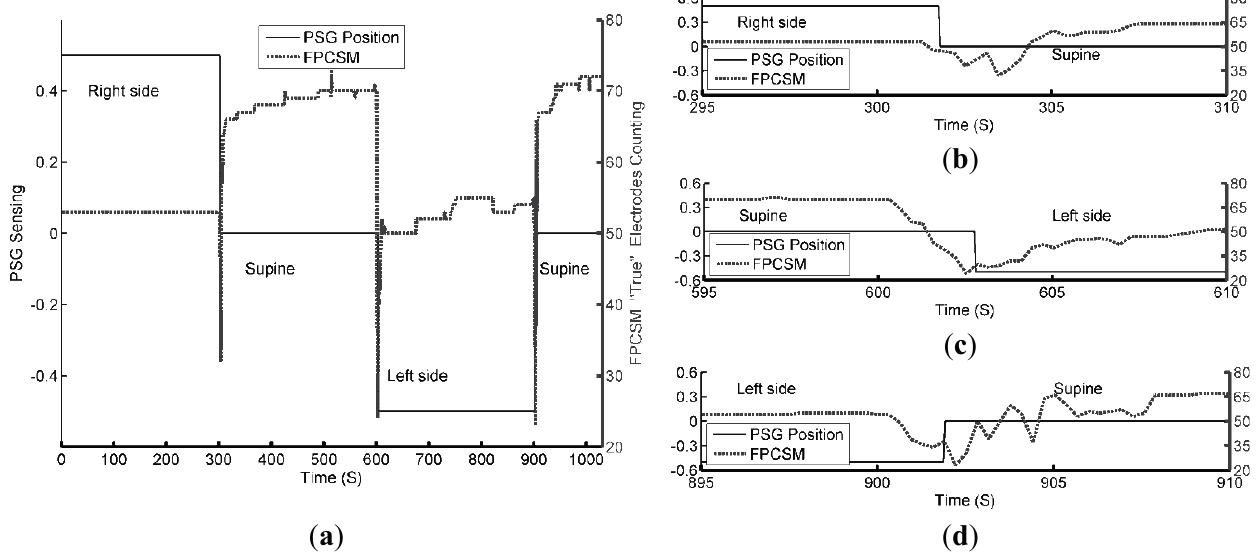
Figure 6. ( a ) PSG postural data and sum of FPCSM electrodes with true values; ( b ) Enlargement of postural data at approximately 300 s; ( c ) Enlargement of postural data at approximately 600 s; ( d ) Enlargement of postural data at approximately 900